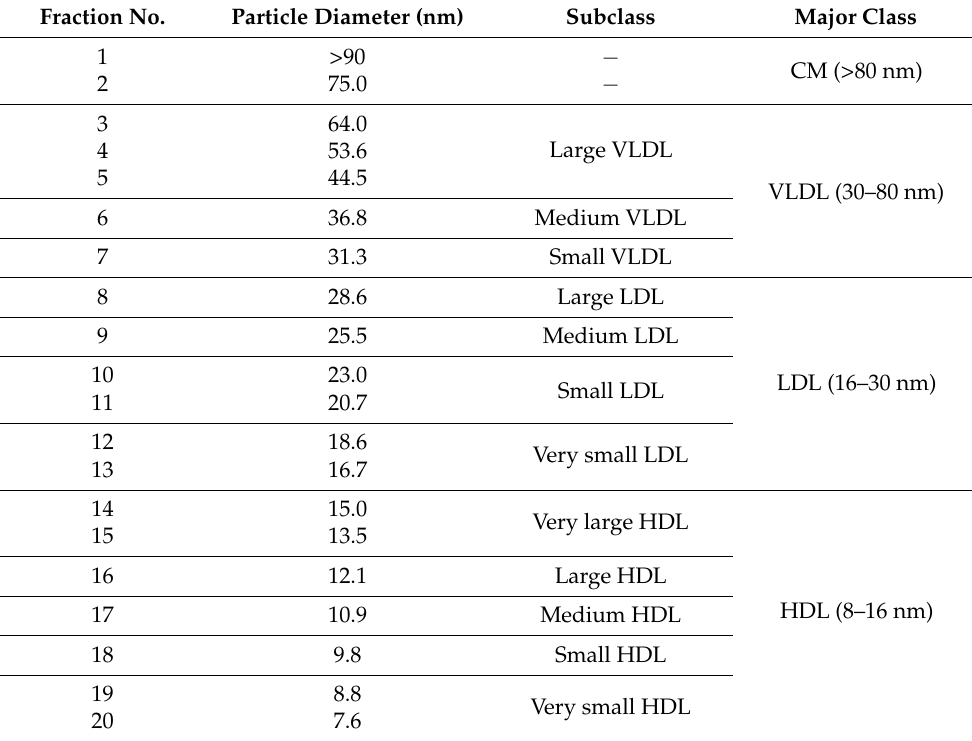
Table 5. Particle diameter in major classes and subclasses of